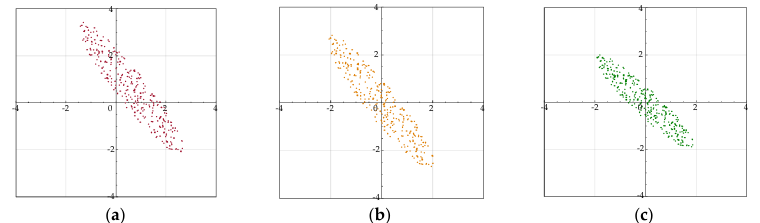
Figure 1. The effect after the treatment of data. ( a ) Original data; ( b ) Centralized data; ( c ) Standardized data.